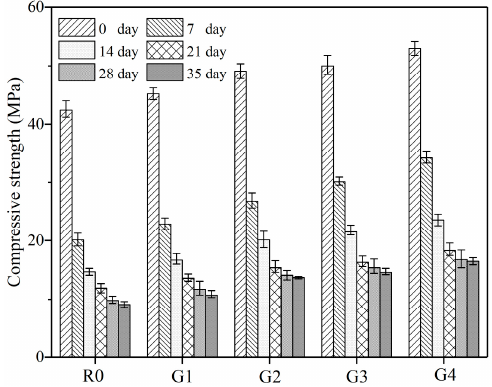
Figure 7. Compressive strengths for the samples leached for 0, 7, 14, 21, 28, and 35 days in 6 mol/L NH 4 Cl solution.